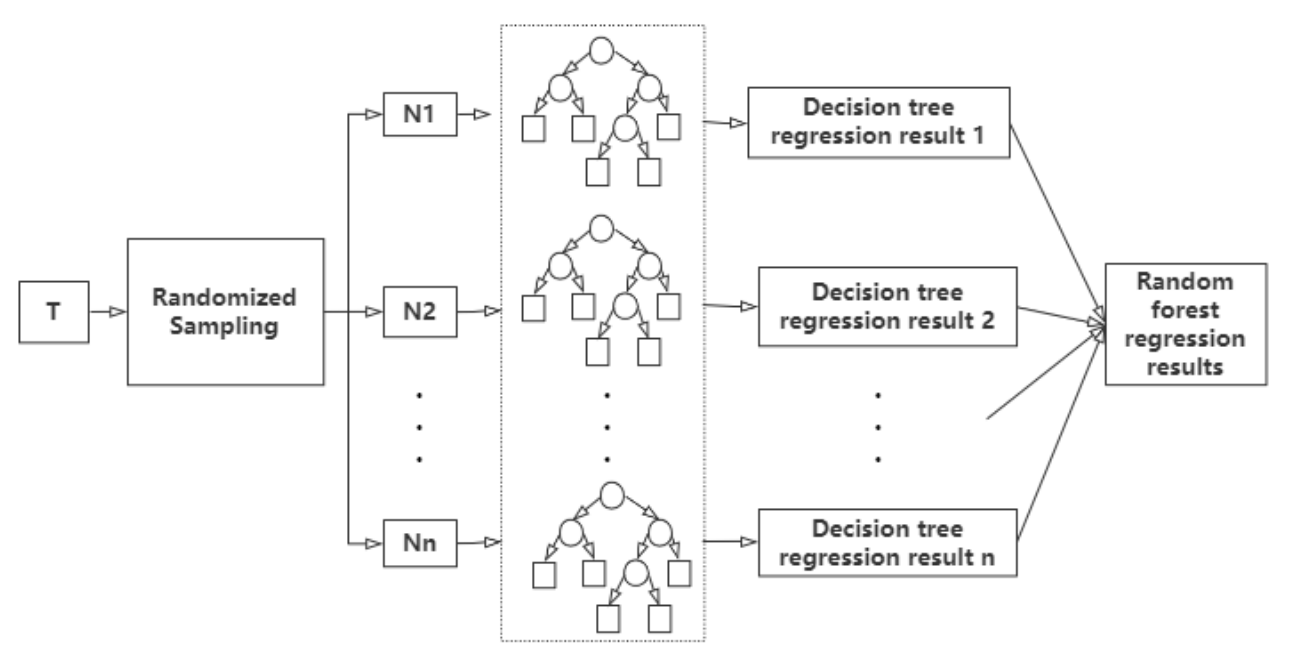
Figure 1. The schematic diagram of random forest regression structure.